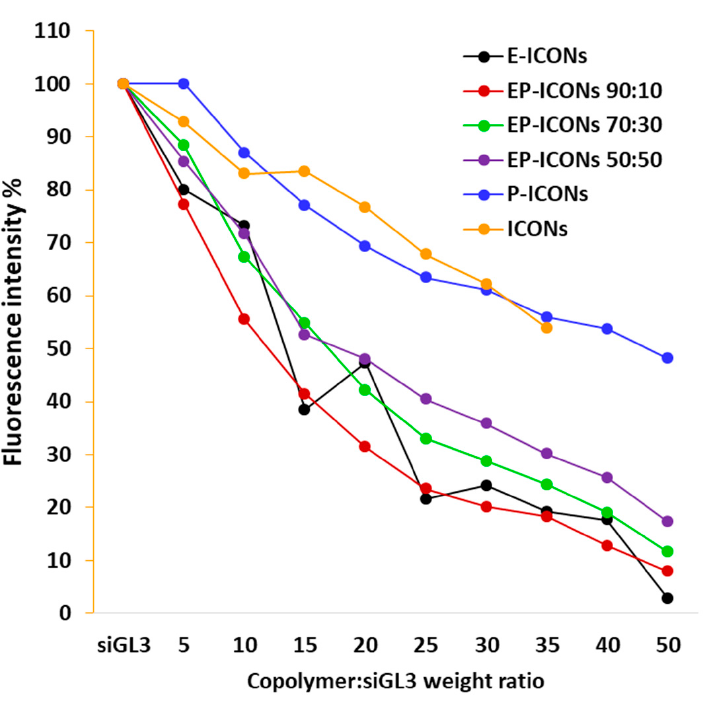
Figure 2. Fluorescence intensity % of ethidium bromide (EtBr) in the presence of unloaded